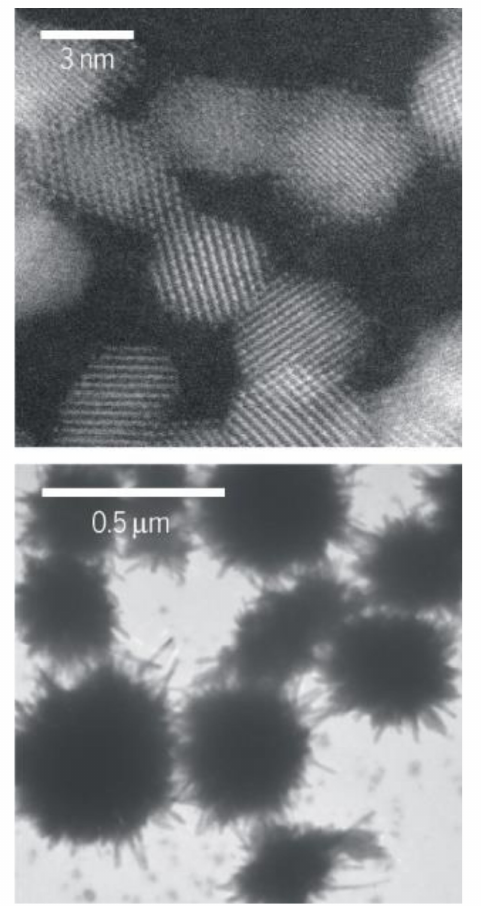
Figure 3. Aging of ceria nanoparticles (NPs). Different holistic properties of young (upper) and aged (lower) ceria NPs after being released into the environment. Reprinted with permission from ref. [57]. Copyright, 2015, The American Association for the Advancement of